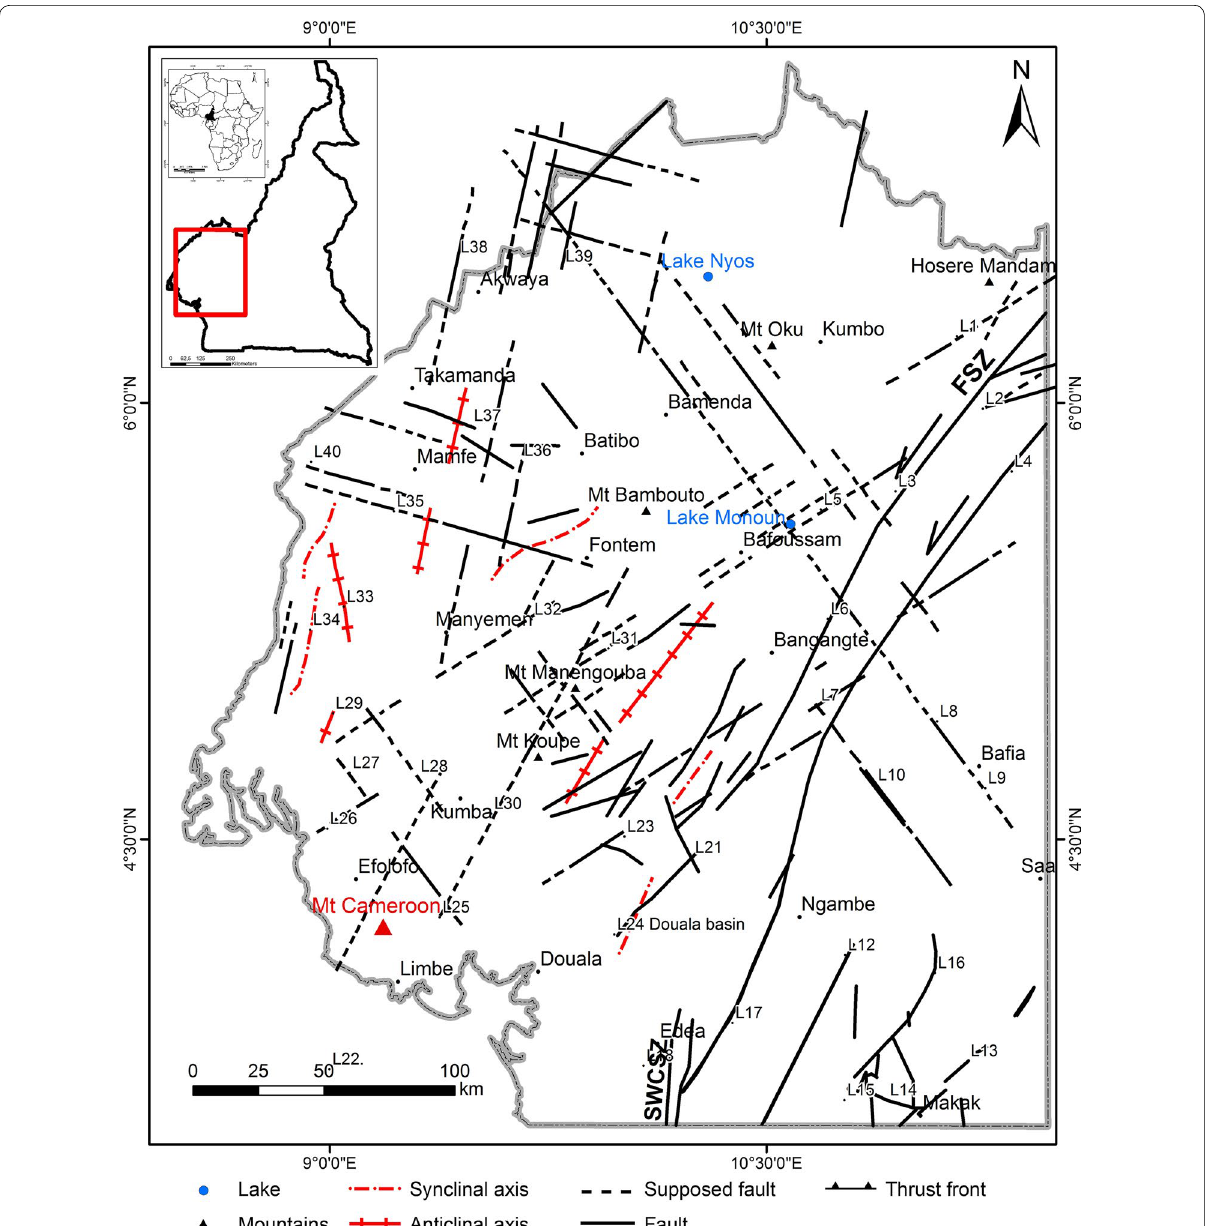
Fig. 3 Synthetic map of the main structural features obtained by previous studies in the study area (adapted from Le Maréchal 1976; Ngako et al. 2008; Van Schmus et al. 2008; Nsifa et al. 2013). The deadly maar lakes are highlighted in blue and Mount Cameroon in